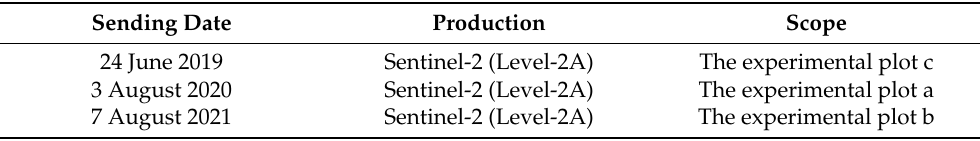
Table 2. Collected information for Sentinel-2 satellite.